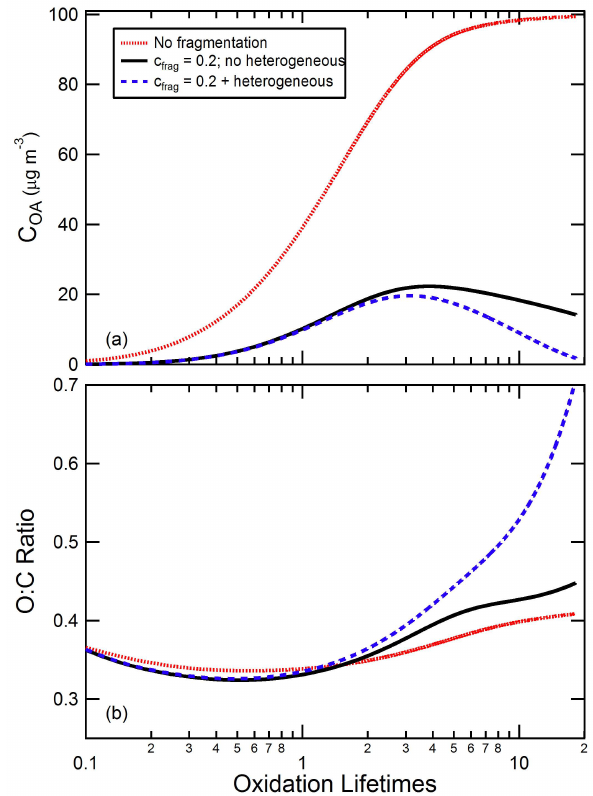
Fig. 12. The variation in the calculated (a) C OA and (b) O:C with the number of SOA precursor oxidation lifetimes for a N C = 12 precursor for different reaction conditions (see legend), including heterogeneous reactions with